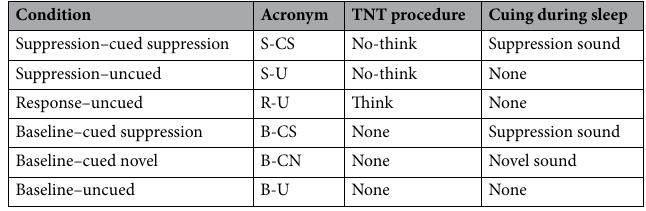
Table 1. Within-subject experimental